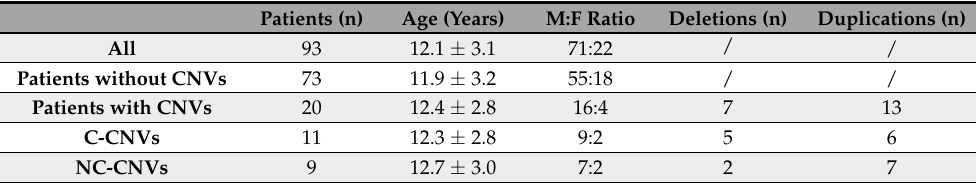
Table 1. Demographic and genetic characteristics of TS patients.